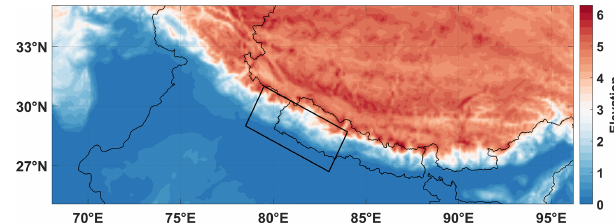
Figure 1. Map of Global Multi-resolution Terrain Elevation Data 2010 (GMTED2010) in kilometres, provided by the US Geological Survey. Thin black lines mark country borders. The black rectangle marks the domain on the foothills of the Himalayas that was used in this